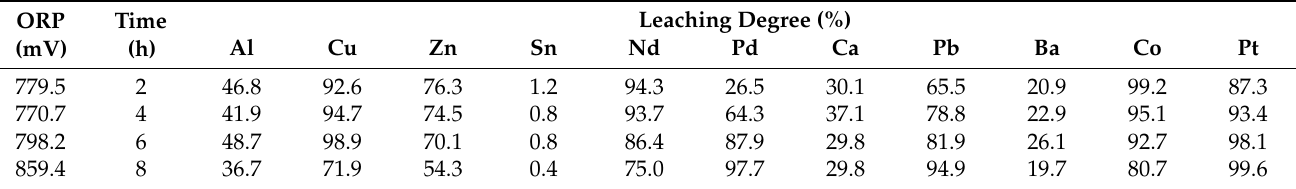
Table 5. Influence of hydrogen peroxide on nitric acidic leaching